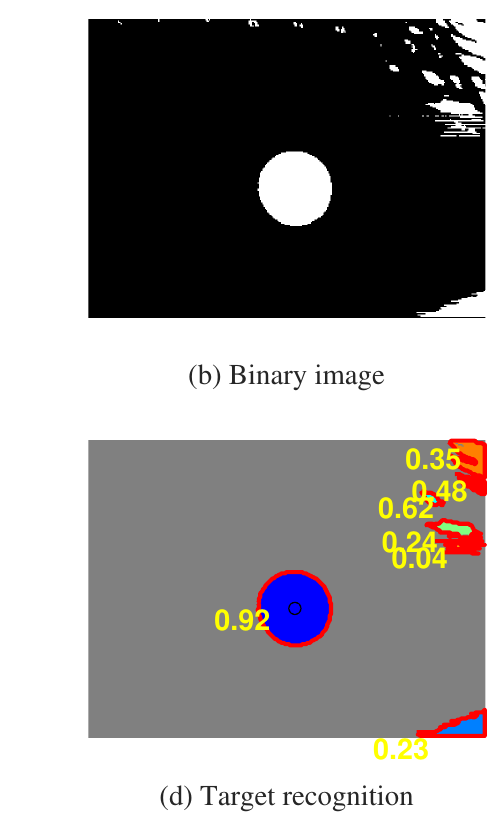
Figure 14. Image aquisition and